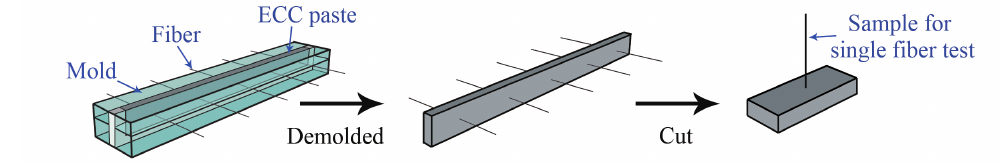
Figure 5. Schematic diagram of single fiber/matrix sample preparation.